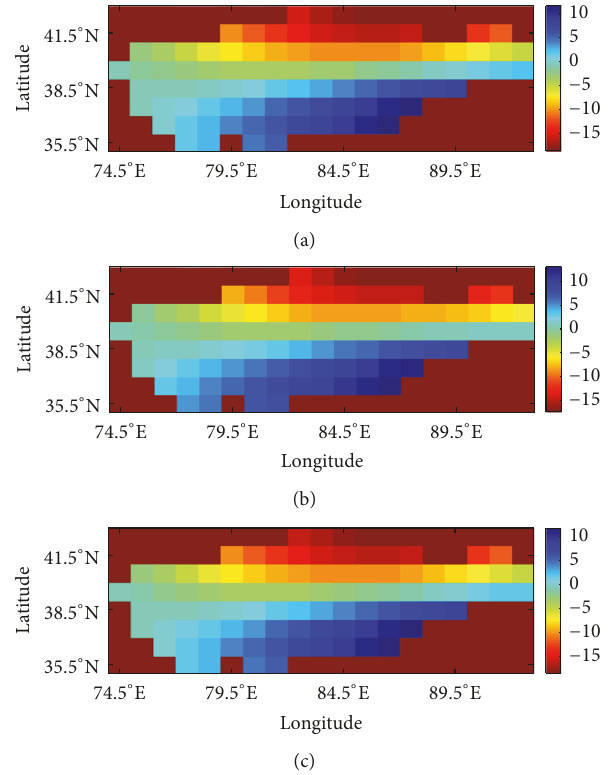
Figure 2: The spatial distribution of TWSA of GRACE. (a) CSR TWSA; (b) JPL TWSA; (c) GFZ TWSA.